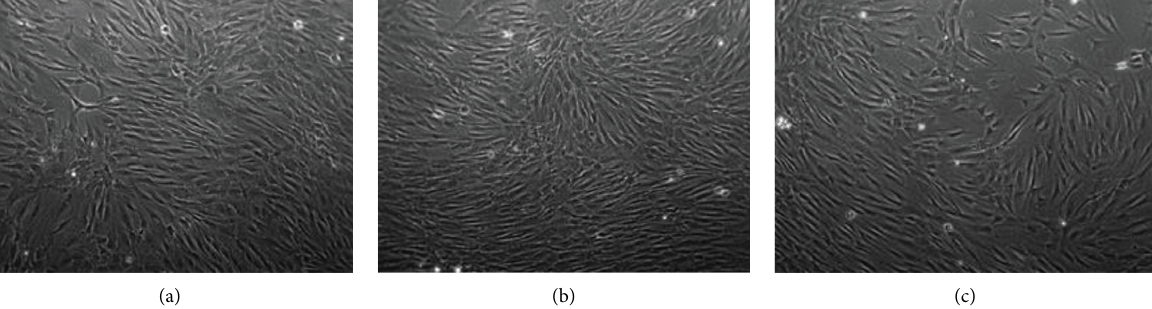
Figure 5: Depiction of the morphology of 3 (a), 8 (b), and 19 (c) months-frozen SCAPs upon thawing shows that no signifcant diference is observed on their typical fbroblast-like morphology in comparison with freshly isolated and cultivated